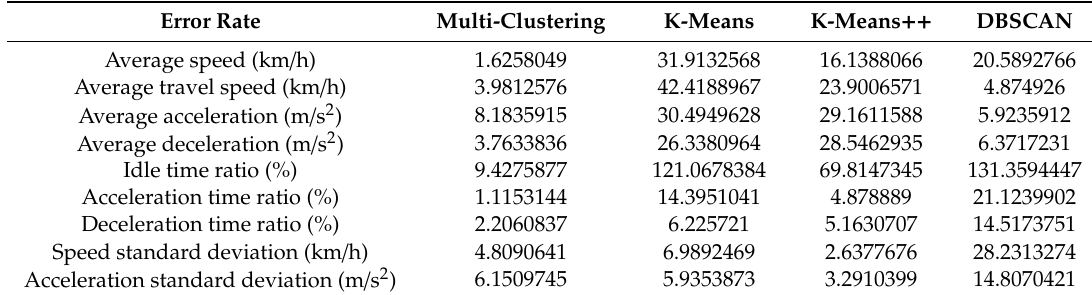
Table 6. Comparison of error rates of each